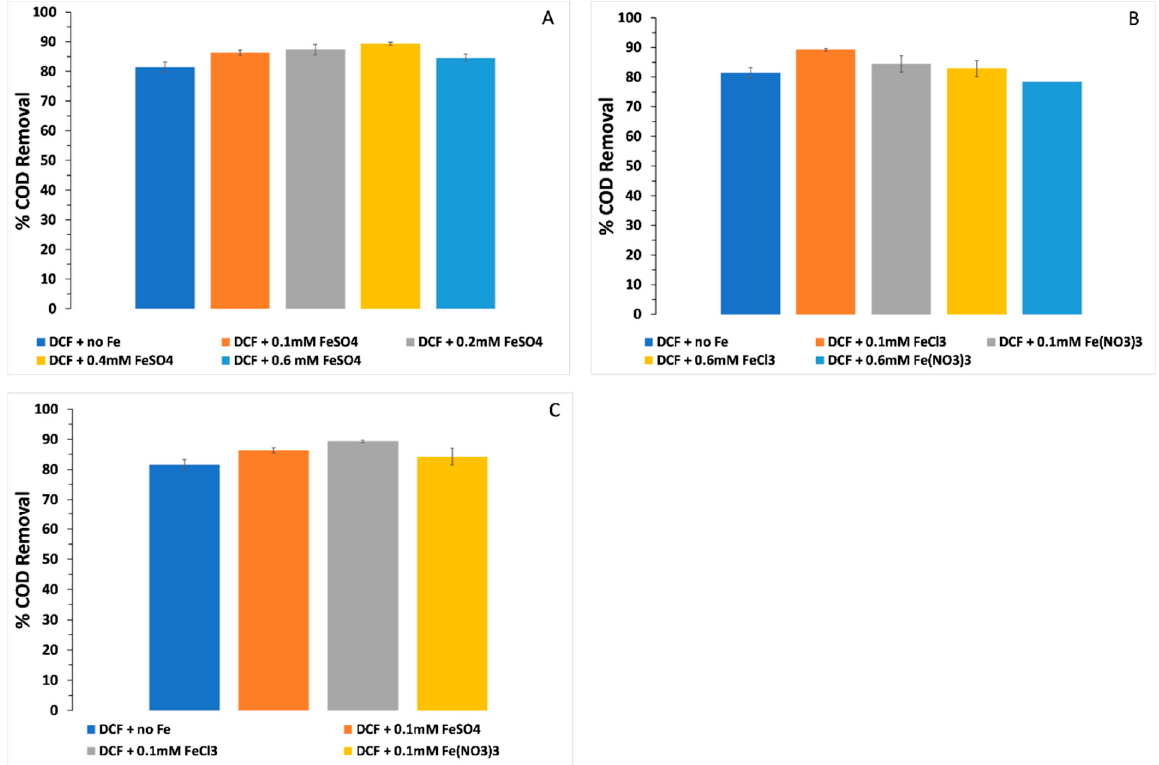
Figure 3. % chemical oxygen demand (COD) removal of DCF in P. citronellolis 620C culture with 1% ( v / v ) DCF as substrate: ( A ) with and without the supplementation of different concentration levels of FeSO 4 , ( B ) with and without the addition of high and low concentration levels of FeCl 3 and Fe(NO 3 ) 3 , ( C ) comparison when different 0.1 mM iron forms were supple- mented.